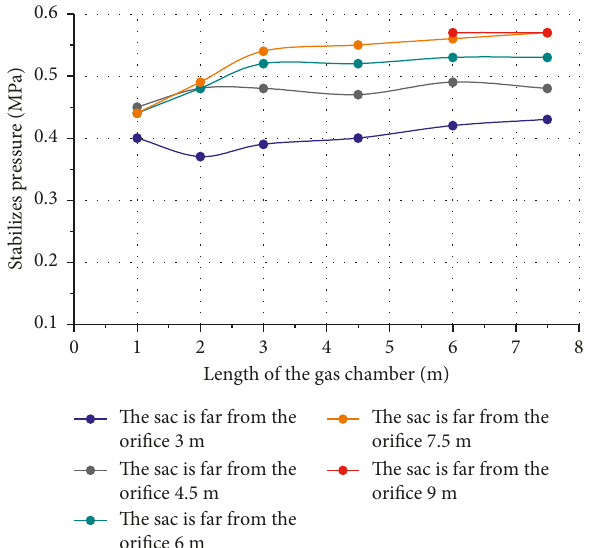
Figure 17: Stable pressure change plot of the same sealing position of the drilled